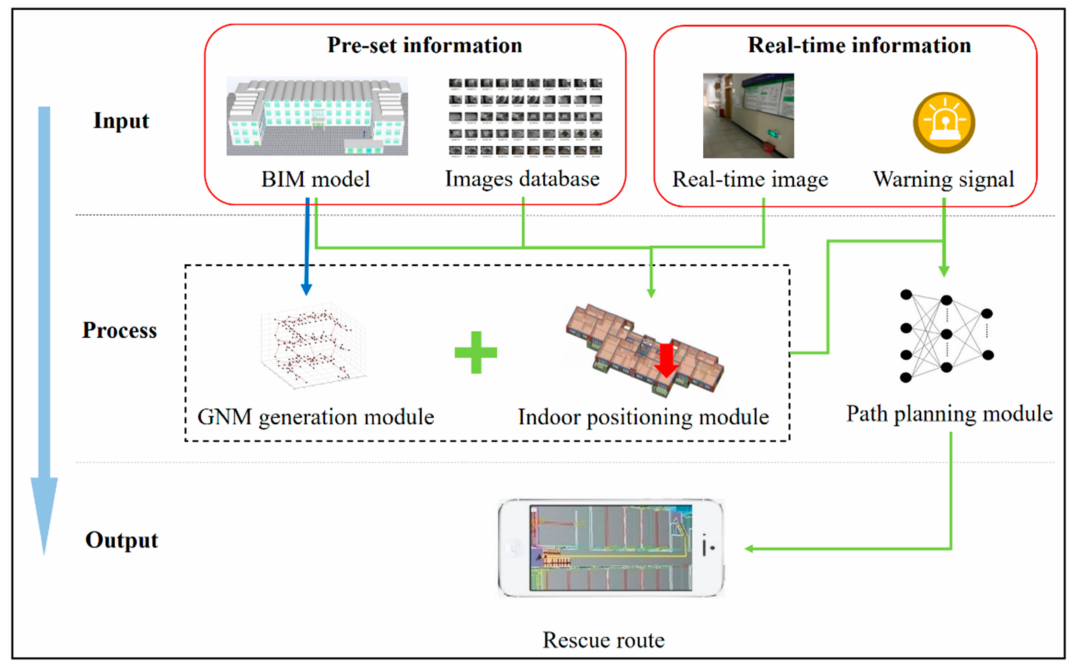
Figure 3. Methodology overview.